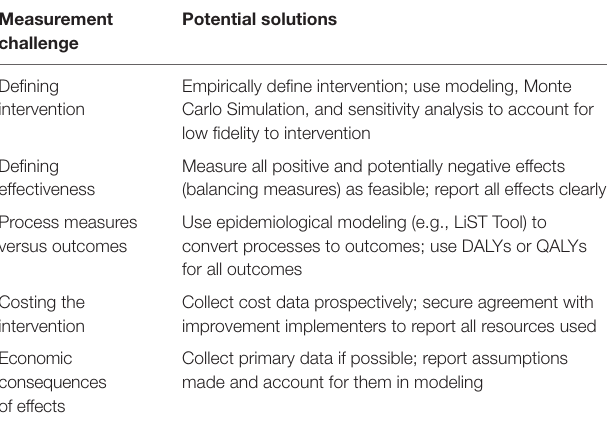
tABLe 1 | Measurement challenges and potential solutions in conducting economic evaluations of health system improvement